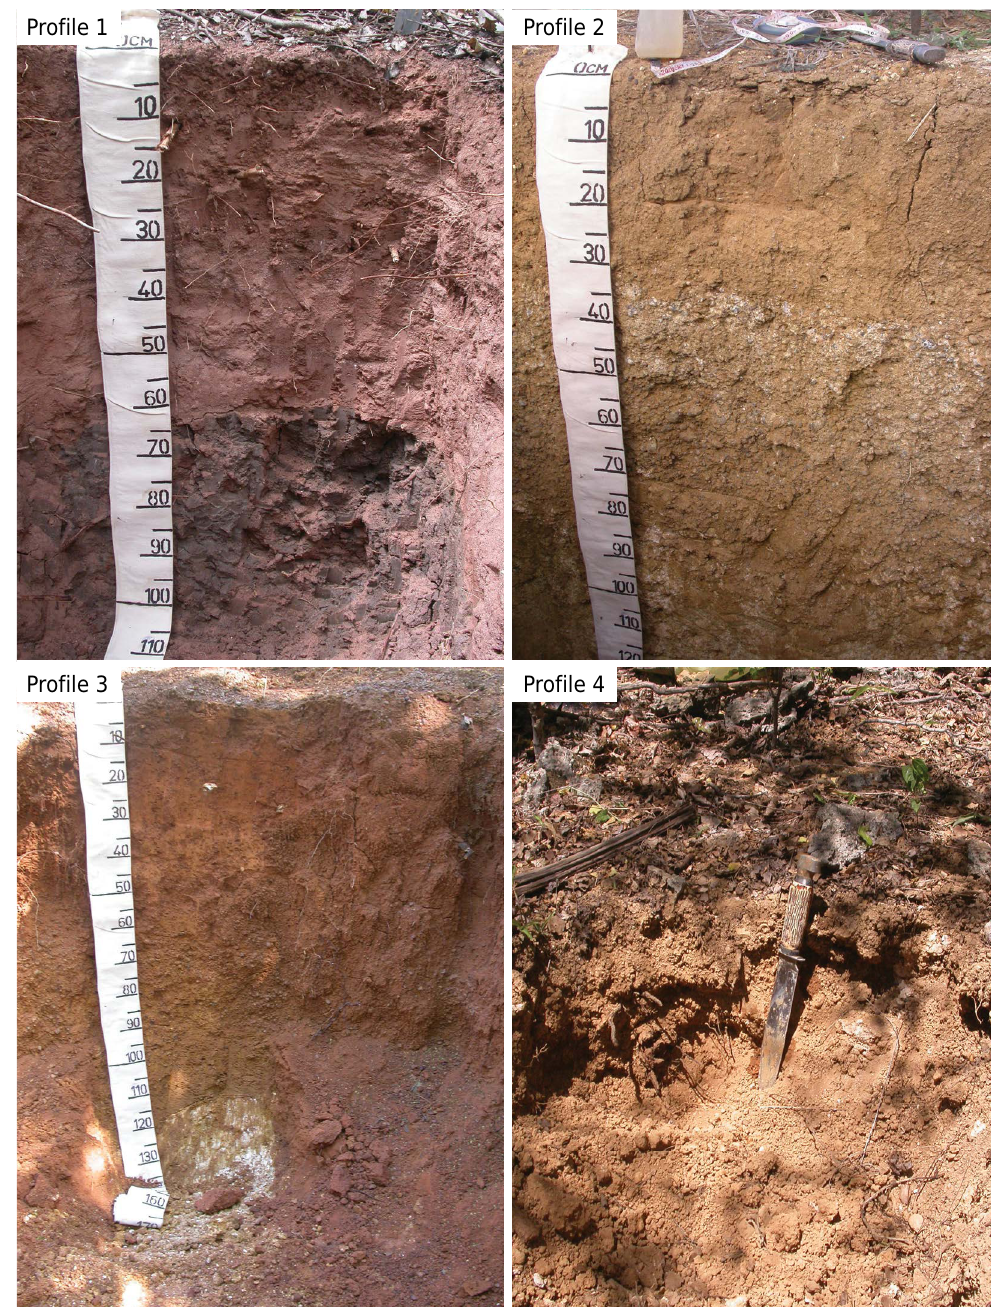
Figure 1. Soil profiles sampled on the Apodi Plateau (Photos by Ricardo